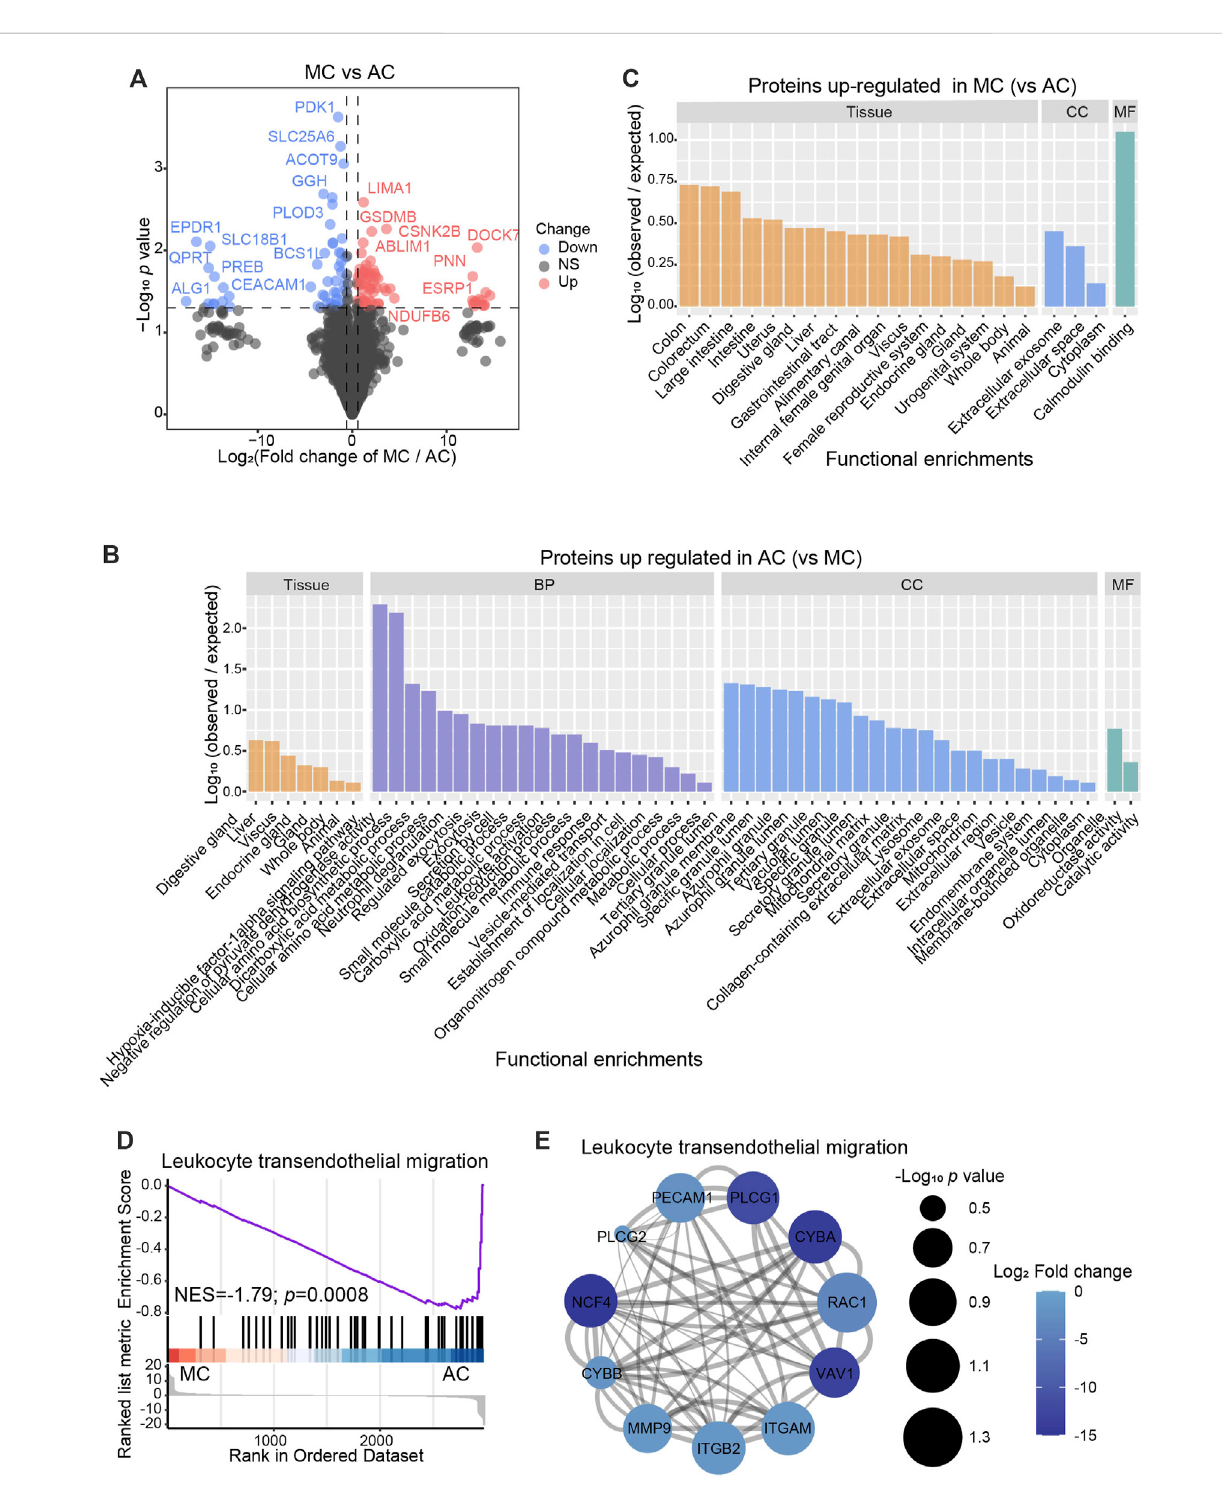
FIGURE 3 Proteomics difference between two types of colorectal adenocarcinomas. (A) Volcano plots showed the differentially expressed proteins between AC and MC. Cutoff: fold change > 1.5, p < 0.05. B – C: Bar plots showed the distribution of tissue expression and gene ontology (GO) analysis, including biological process (BP), cellular component (CC), and molecular function (MF), which was enriched with proteins upregulated in AC (B) or MC (C) . (D) Gene set enrichment analysis (GSEA) showed the top signi fi cantly enriched hallmark between AC and MC. (E) Networks presented proteins of the topGSEAbetweenACandMC.Colorbar:-log 10 (proteinexpression p -valueofACandMC).Circlesize:-log 10